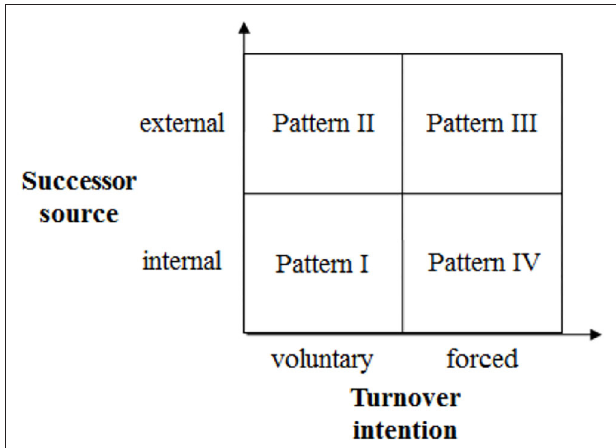
FIGURE 1 | CEO turnover